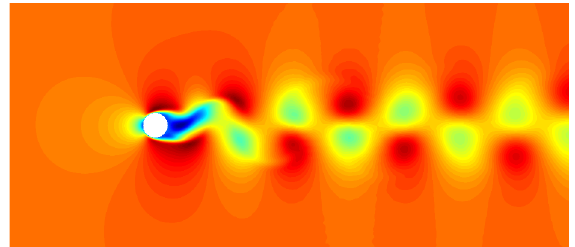
Figure 3. Cylinder wake flow at Re = 200. Iso-values of the longitudinal velocity fluctuation where the B´enard von-K´arm´an vortex shedding is clearly visible.